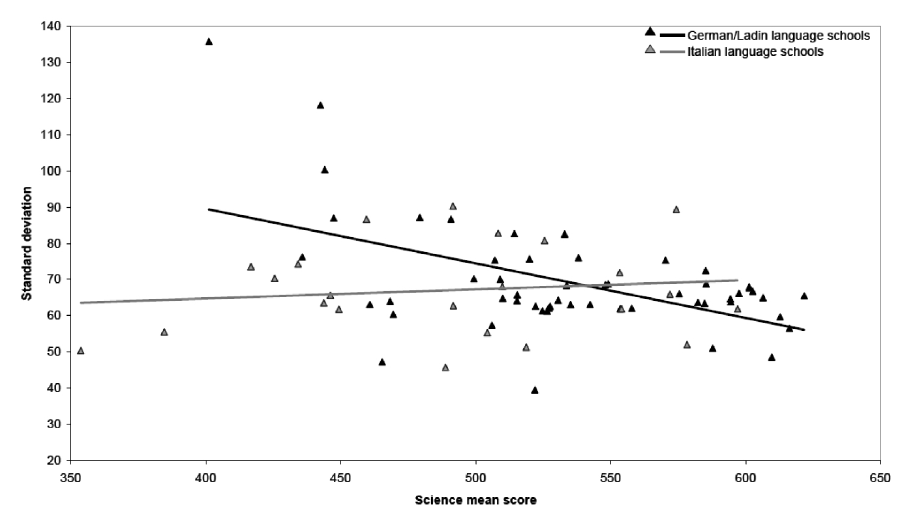
Figure 1 – Relation between school mean science score and scores’ standard